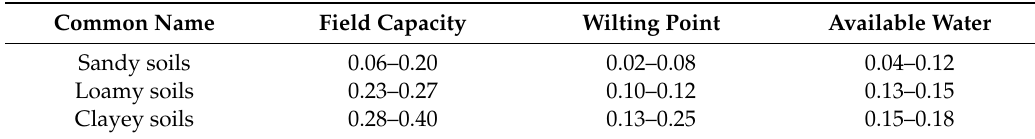
Table 2. Average values of available water holding capacity of the main soil texture groups (cm of water per cm of soil). Data adapted from